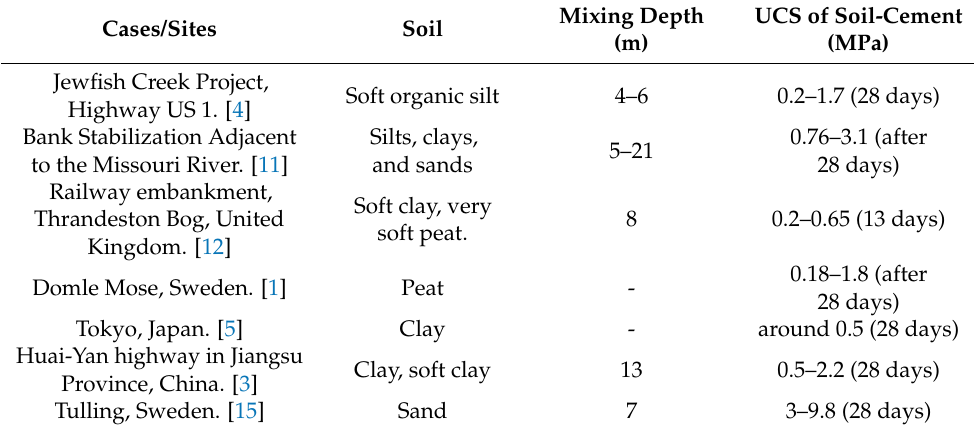
Table 1. Field applications of dry soil